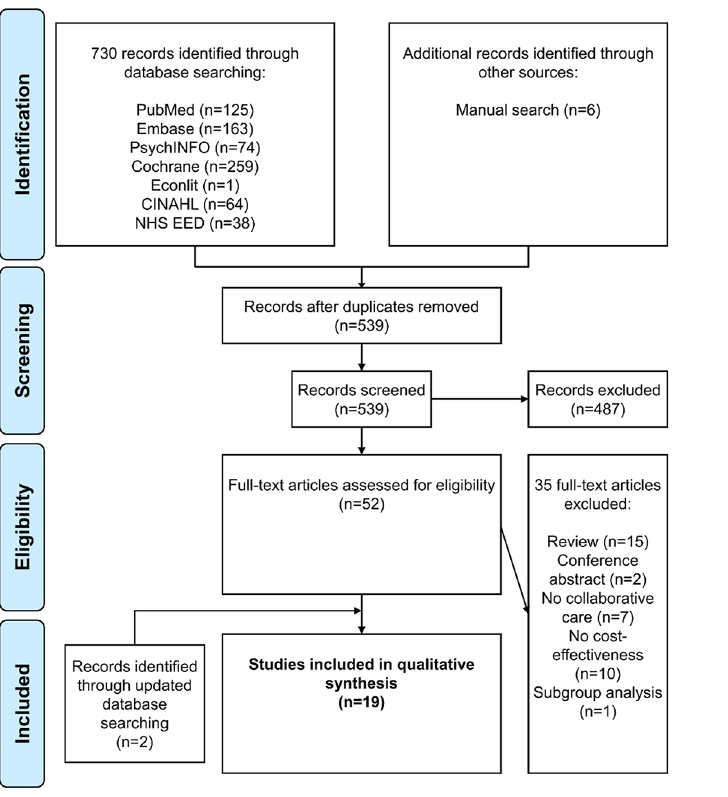
Fig 1. Flow chart of the selection process based on the PRISMA Statement